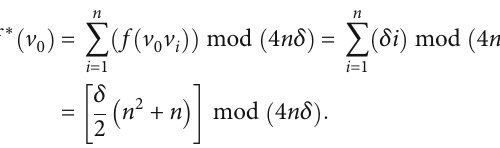
− graceful 11 with edge 5